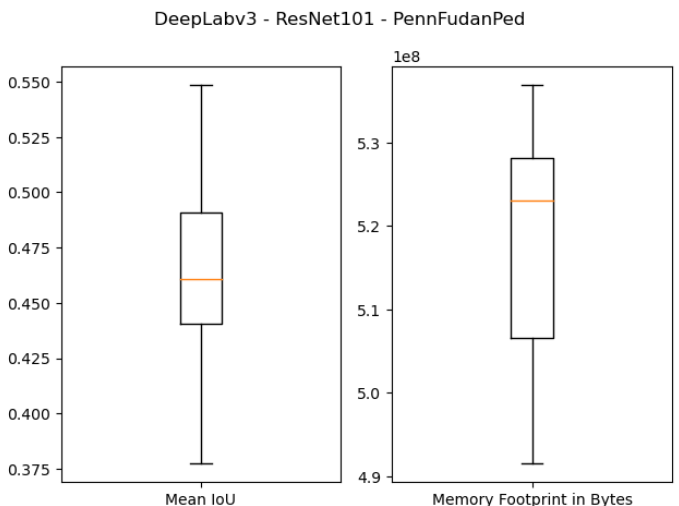
Figure 14. Boxplot results for the Penn–Fudan dataset using the ResNet101 backbone and 512 MB of desired memory